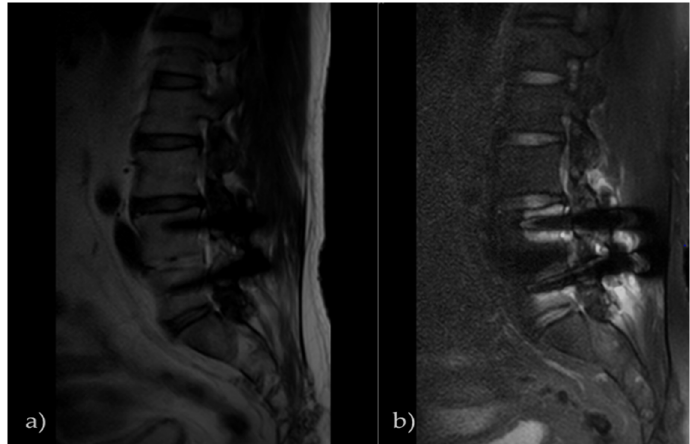
Figure 8. T2 CS-SEMAC image of transplant patients. In musculoskeletal testing, if there is a metal material, the image to which the fat suppression technique was applied shows a great signal loss. This is an image that compared Image ( a ) to which the FS technique was not applied and Image ( b ) to which it was applied. MAR was less in Image ( a ) than in Image ( b ).